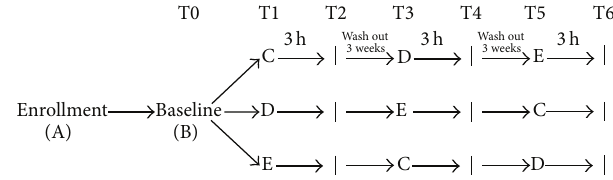
Figure 1: Study design and intervention. The randomized crossover study was divided into 4 nutritional intervention treatments (T0, T1, T3, and T5). The collection of blood sample was detected to 3 hours to each intervention. Between every nutritional intervention, a wash-out period was inserted. In each treatment period subjects consumed (B) baseline (fasting); (C) McDonald’s meal; (D) McDon- ald’s meal with 250 mL of not pruned vineyard red wine; (E) 250 mL of not pruned vineyard red wine. Nutrition status was detected at step (A). The blood sample for nutrigenomic and biochemical analysis was collected at the end of each treatment period (T0, T2, T4, and